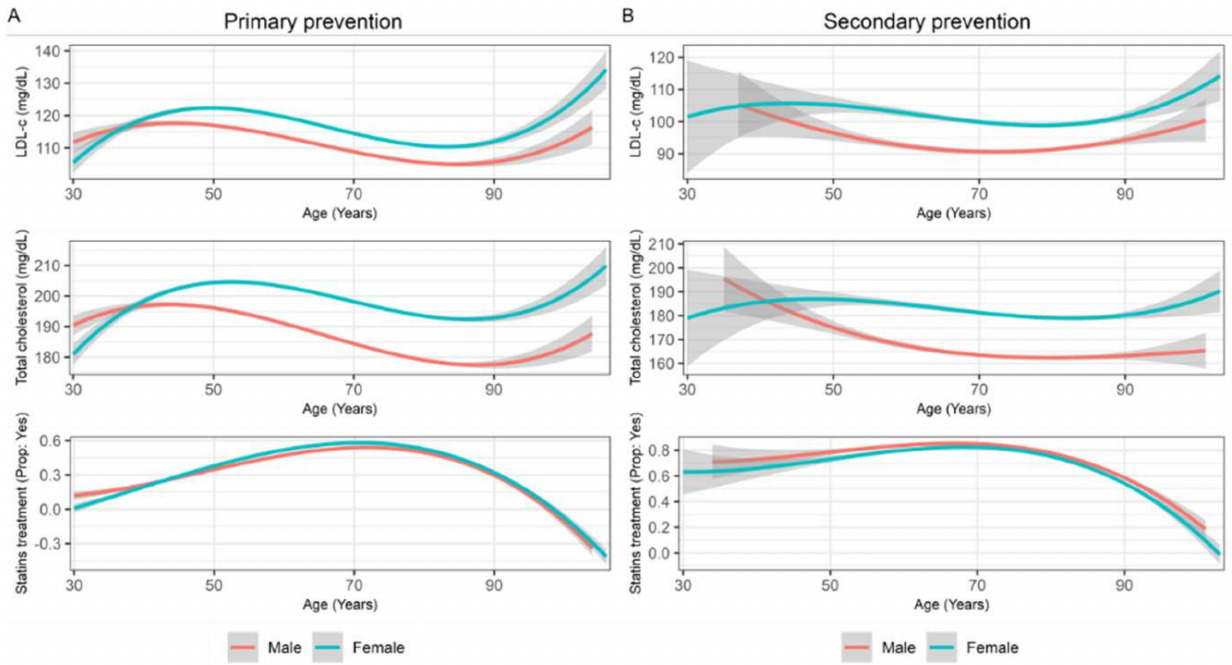
Figure 2. Smoothing line charts with changes in LDL-c, total cholesterol, and statin treatment across age in subjects on primary prevention ( A ) and secondary prevention ( B ) by gender (LDL-c, low-density lipoprotein cholesterol).